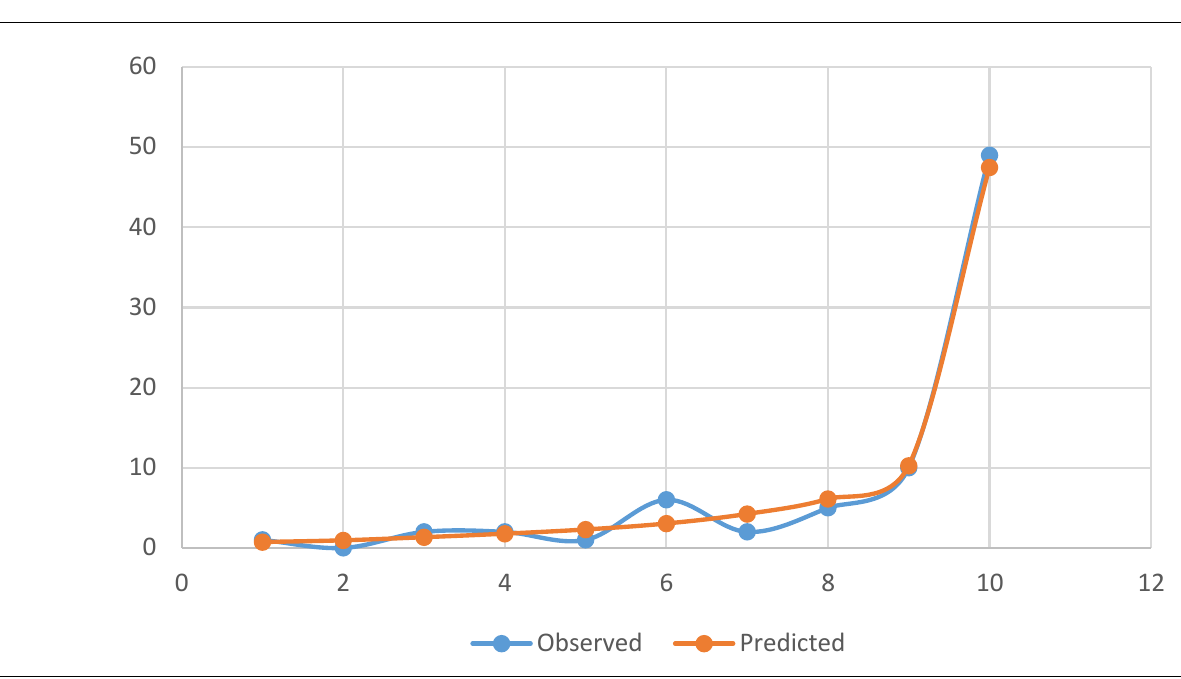
Fig. 2 – The logistic regression’s goodness of fit in the propensity score-match model. χ2=7.43,